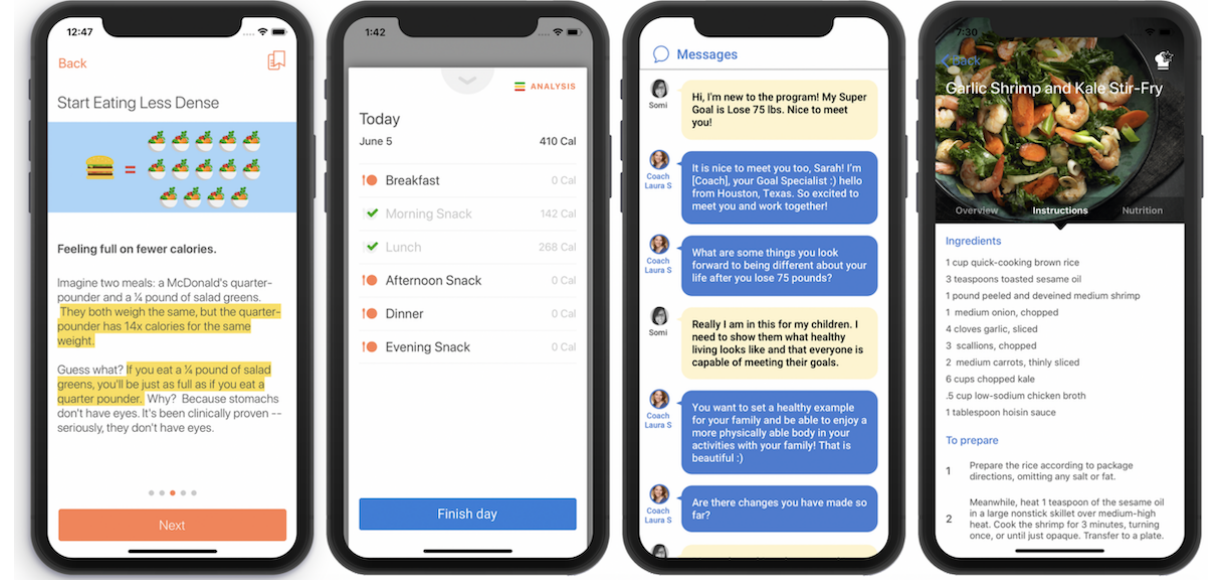
Figure 1. Selection of screen pages for mobile health